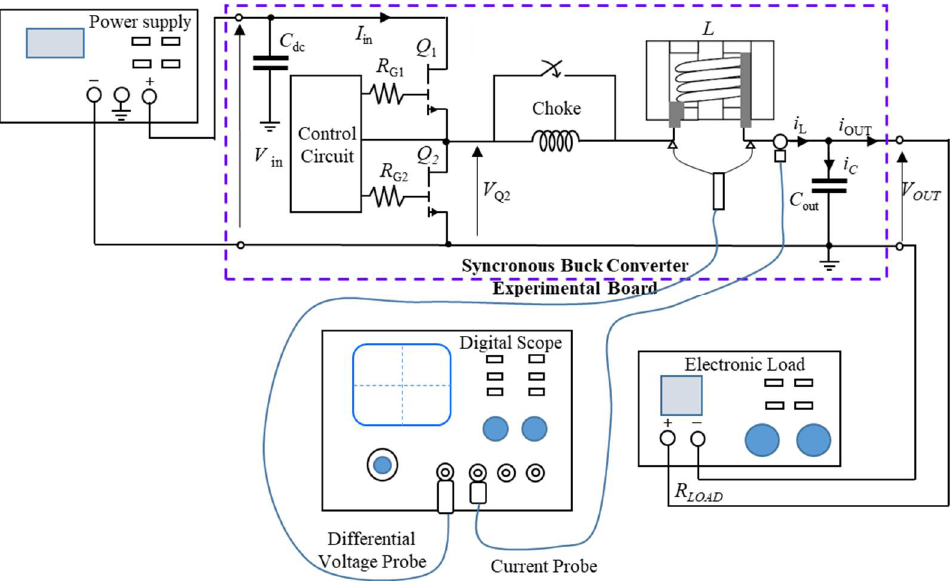
Figure 1. Circuit diagram of the experimental setup for DC thermal steady-state differential inductance identification. A high inductance choke allows imposing negligible current ripple on the inductor under test. After reaching the DC thermal steady-state for a given average output current, the choke is short-circuited, and the inductor voltage and current waveforms are measured with a digital oscilloscope.